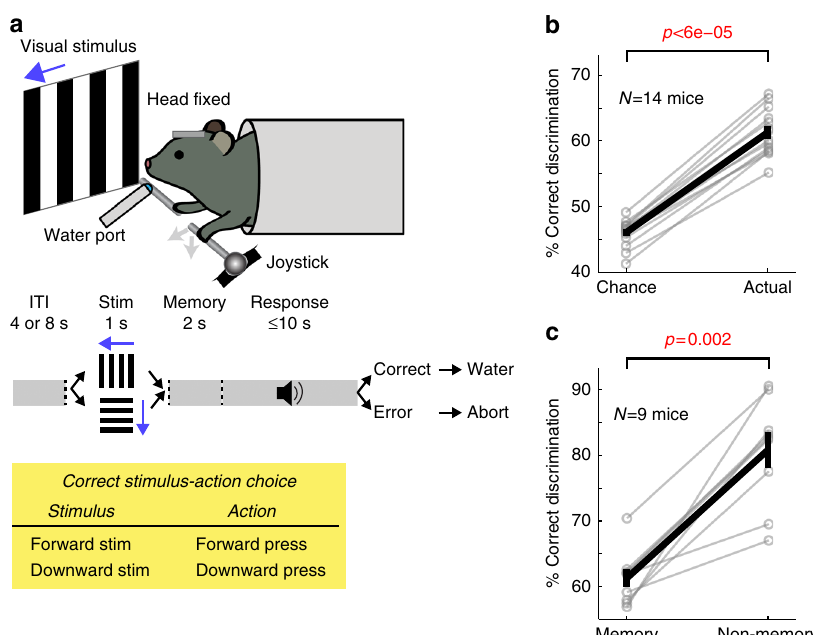
Fig. 1 Task. a Top: task schematic. Middle: task trial structure. Bottom: stimulus-action-outcome rule. b Fraction of correctly discriminating trials is signi fi cantly greater than chance. Black, mean ± s.e.m. across mice; gray, individual mice. Wilcoxon one-sided signed rank test. c Fraction of correctly discriminating trials is signi fi cantly greater in non-memory trials (visual stimulus stays on throughout the trial) when randomly interleaved with memory trials. Black, mean ± s.e.m. across mice; gray, individual mice. Wilcoxon one-sided signed rank